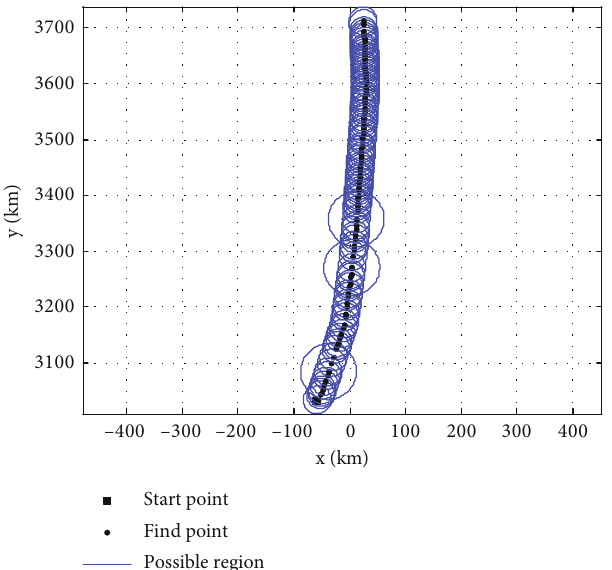
Figure 13: Simulation result of ship ’ s 24-hour voyage tracking process.